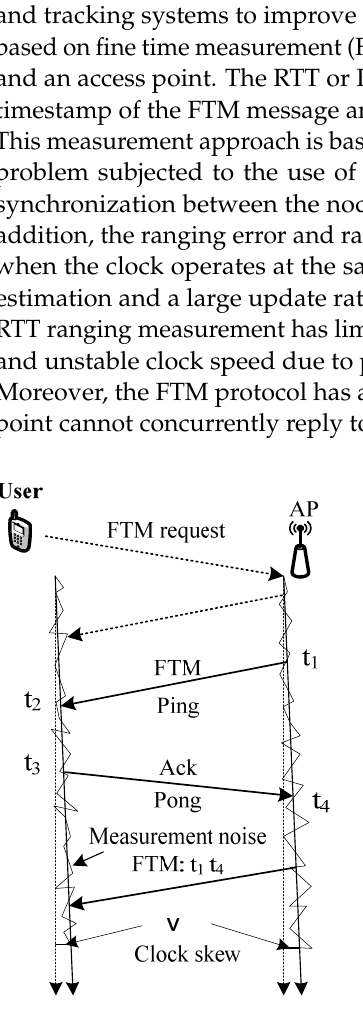
Figure 5. RTT with a skewed clock.